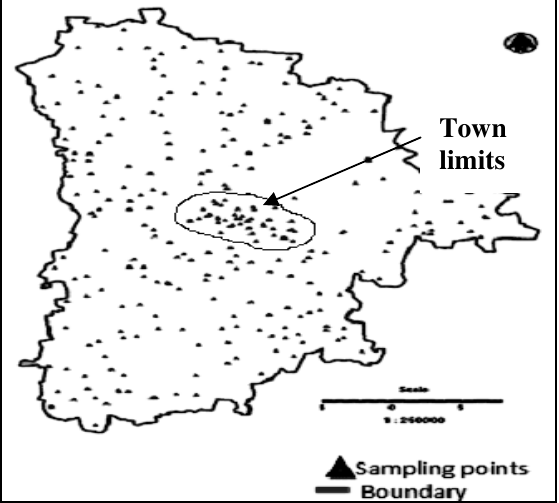
Figure 3. Groundwater sampling